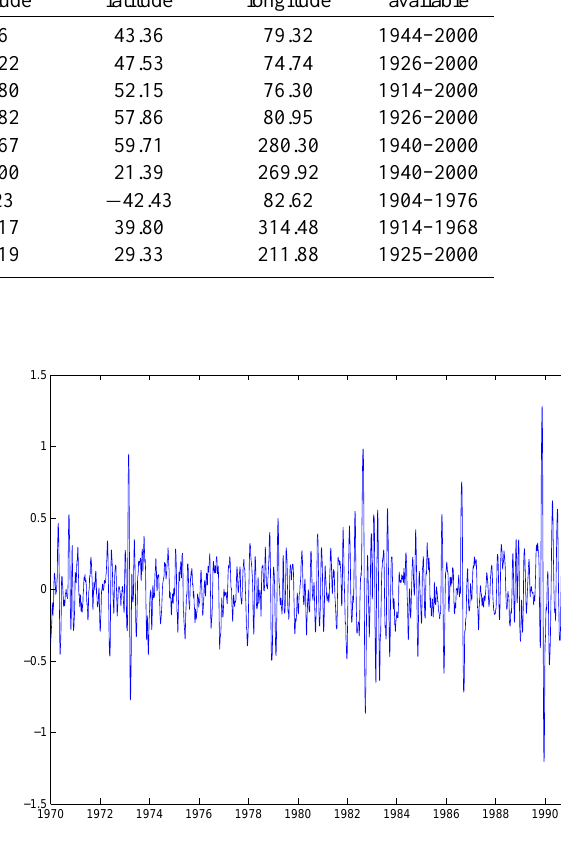
Fig. 2. HAD observatory. Function η p (k) (Eq. (1) of main text), with p = 61. Vertical unit :